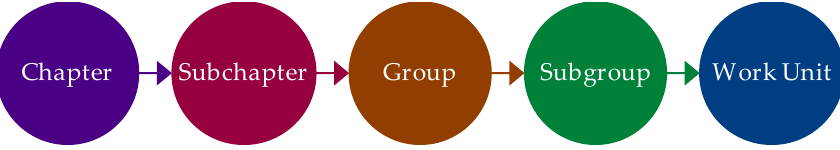
Figure 4. Hierarchical structure of Spanish construction price databases.